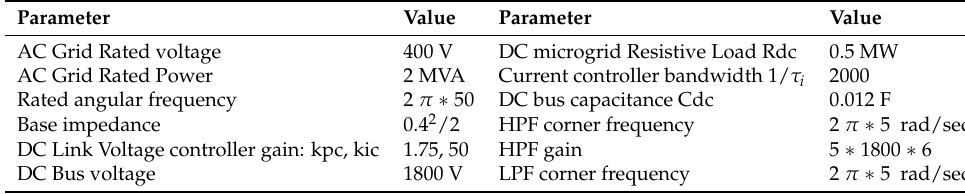
Table 2. The proposed control system parameters.